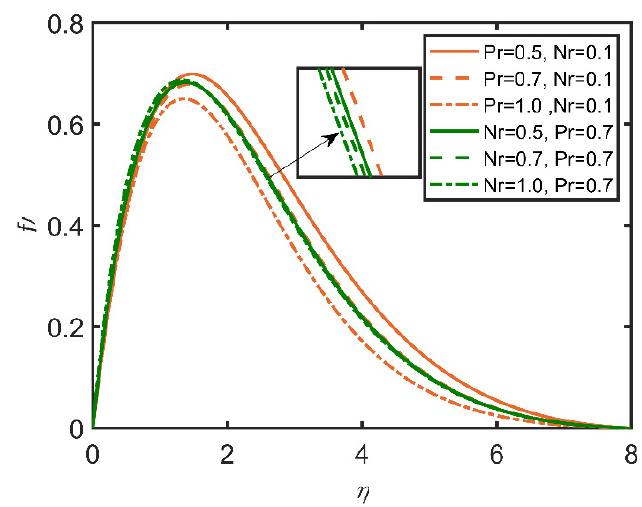
Figure 13. Comparison for velocity profile against 𝜂 .